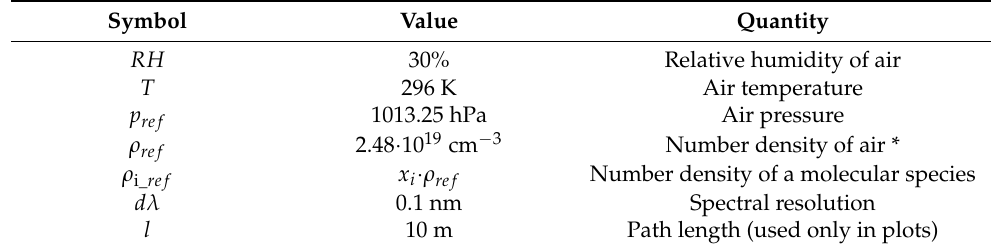
Table 3. Parameter set-point during spectrum